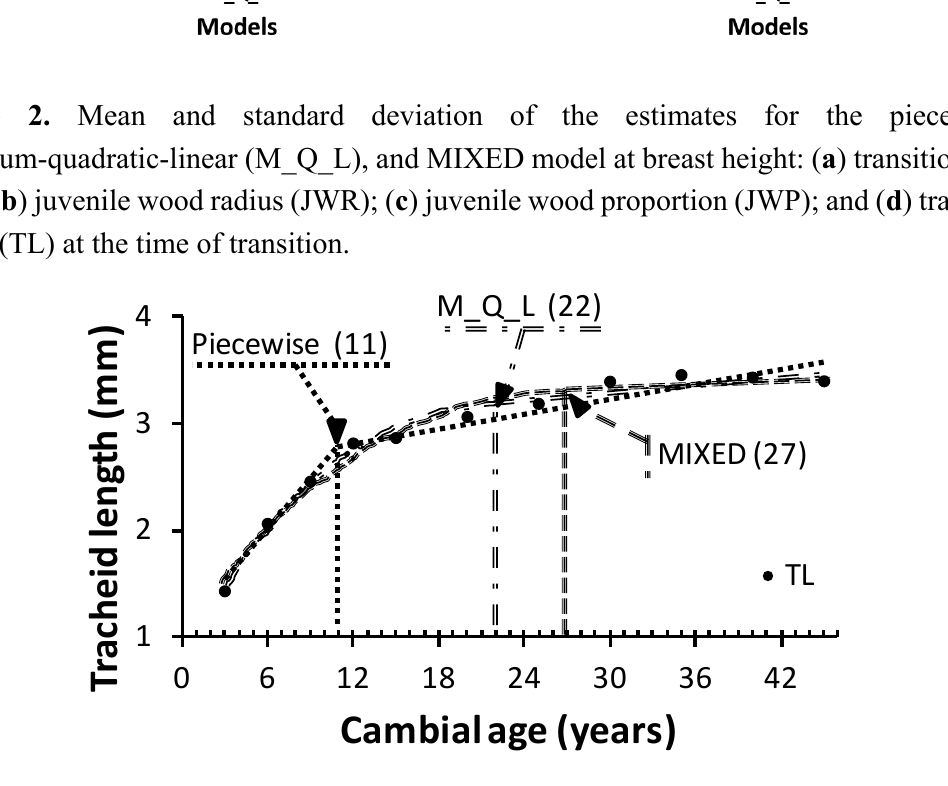
Figure 3. Graphical representation of the average transition ages determined with the piecewise, maximum-quadratic-linear (M_Q_L), and MIXED model, and average tracheid length at breast